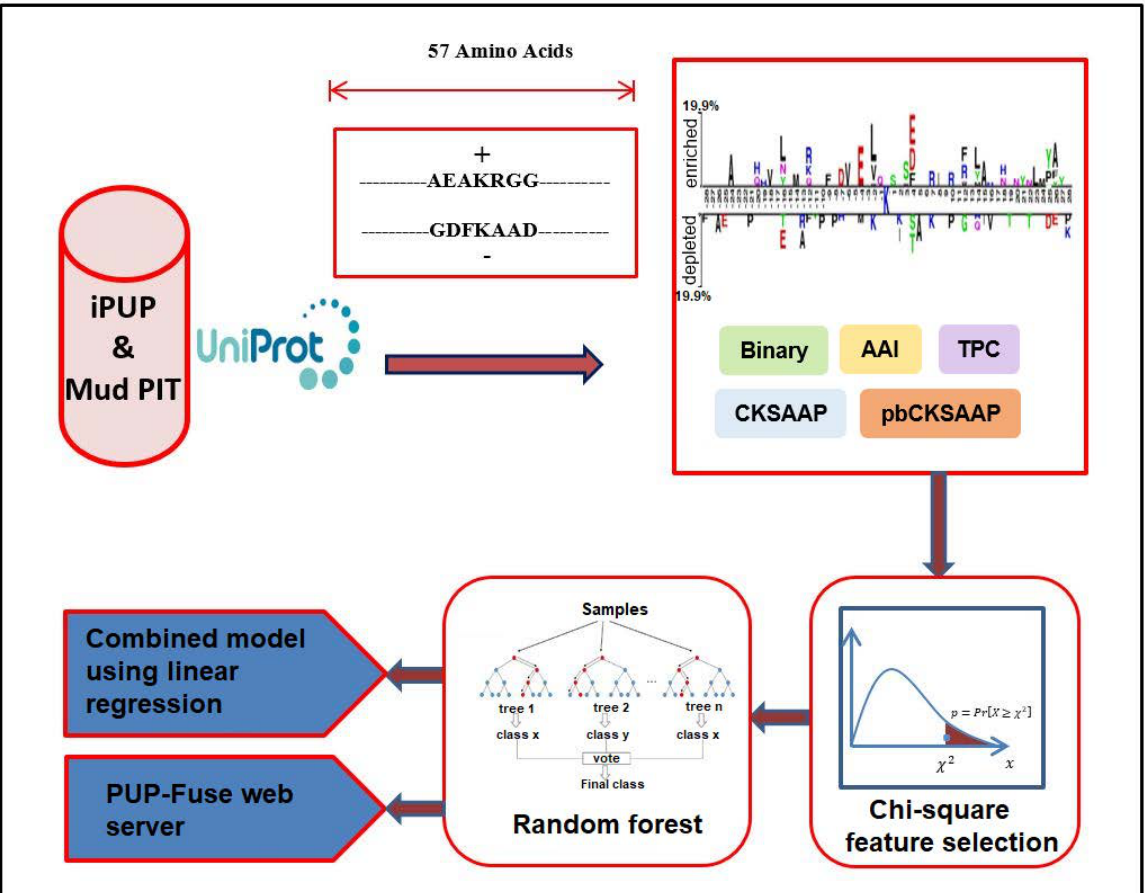
Figure 1. An overview of the proposed PUP-Fuse